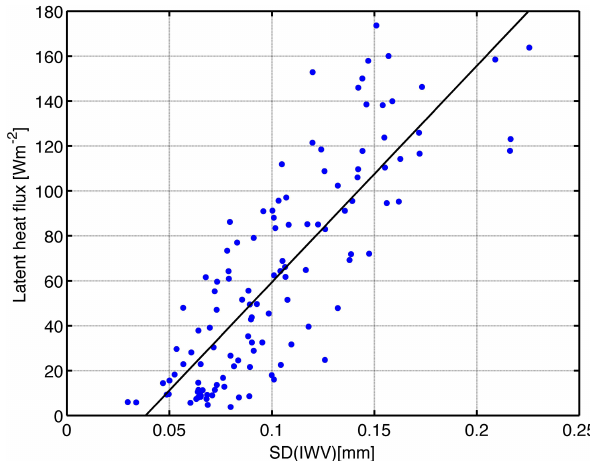
Figure 8. Scatter plot of SD(IWV) and the latent heat flux measured by TROWARA at Bern in 2010. The parameters are described in detail in Fig.